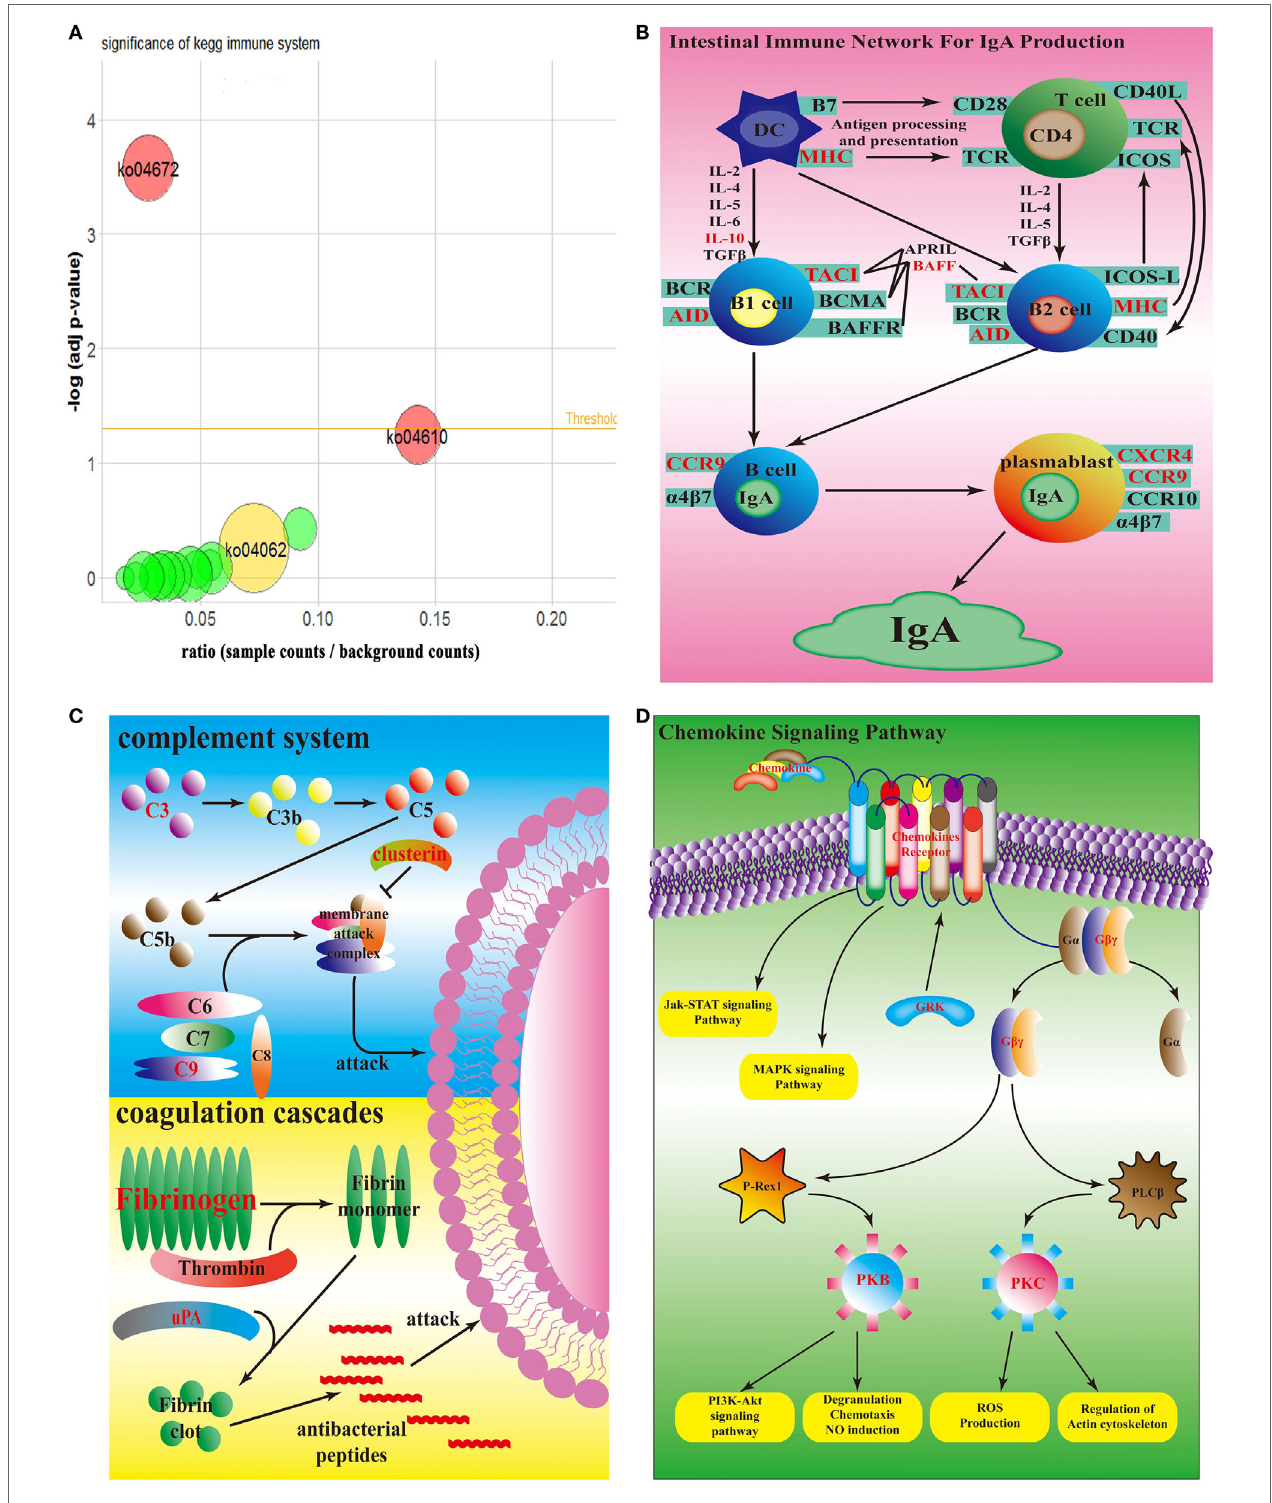
FigUre 4 | Top enrichment KEGG pathway. (a) Bubble graph of top enrichment KEGG pathway. Red bubbles are remarkable pathway (adj p -value < 0.05); yellow bubble is the pathway which has the most number of differentially expressed genes; green bubbles are other pathways. (B) Simplified overview of sigX -RNAi strain interacting with the host intestinal immune network for IgA pathway. (c) Simplified overview of sigX -RNAi strain interacting with the host coagulation and complement system. (D) Simplified overview of sigX -RNAi strain interacting with the host chemokine signaling pathway. The black letter genes in (B–D) represent no different expression and the red letter genes in (B–D) are up-regulated in spleen infected by sigX -RNAi strain compared with the counterpart infected by wild-type